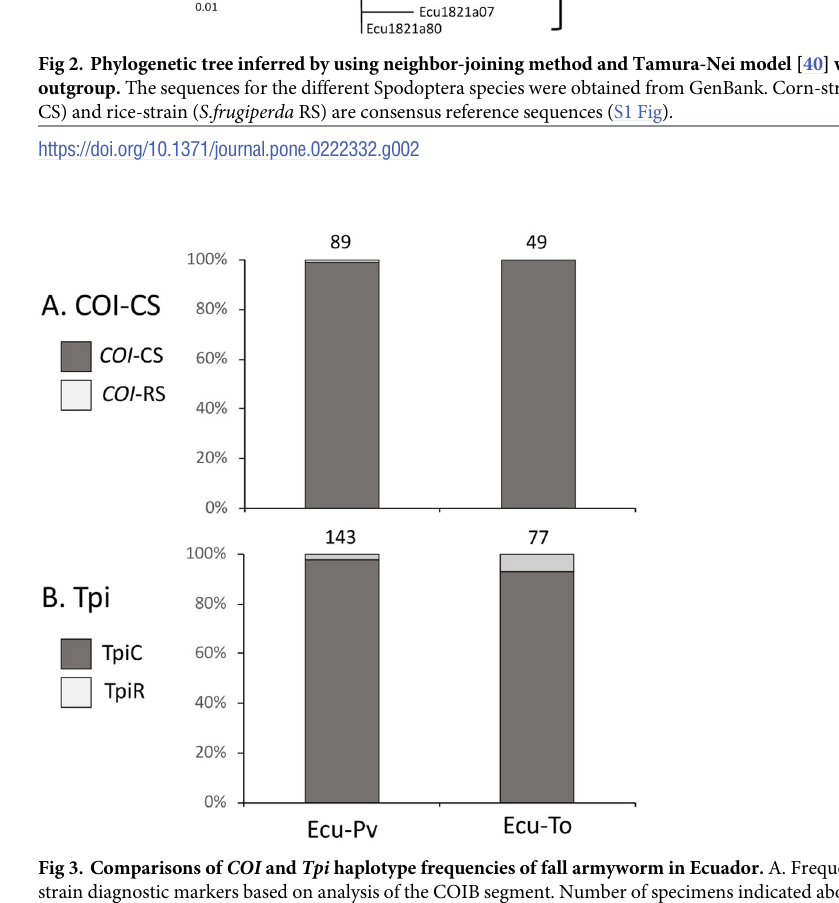
PLOS ONE | https://doi.org/10.1371/journal.pone.0222332 September 19,